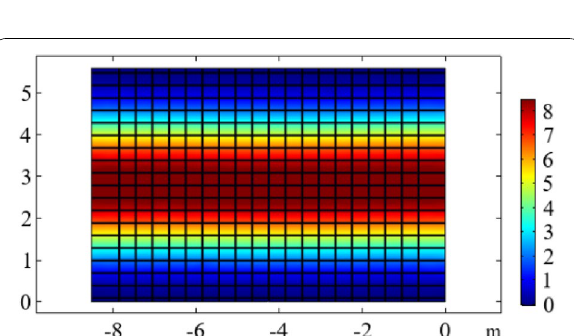
Fig. 5 Displacement (unit: mm) of the barricade after 24 h stope